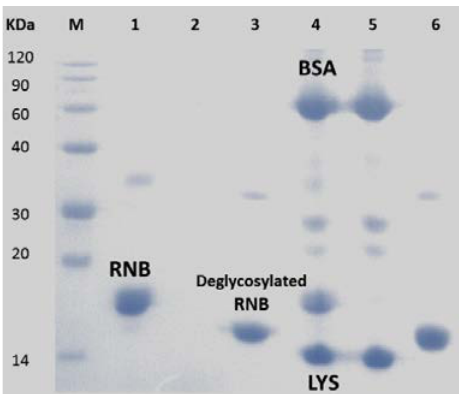
Figure 7. SDS–PAGE analysis of the model glycoprotein proteins before and after treatment with MSP@PNAMAm-1 core-shell microspheres. M stands for protein marker; Lane 1 represents the RNase B; Lane 2 represents the supernatant after enrichment with MSP@PNAMAm-1; Lane 3 represents the released deglycoslated RNB after enrichment; Lane 4 represents the protein mixture of BSA, RNB(RNase B)and LYS(The amount of BSA:RNB:LYS = 1:1:1); Lane 5 represents the supernatant of the protein mixture after enrichment; Lane 6 represents the released deglycosylated RNB after enrichment.